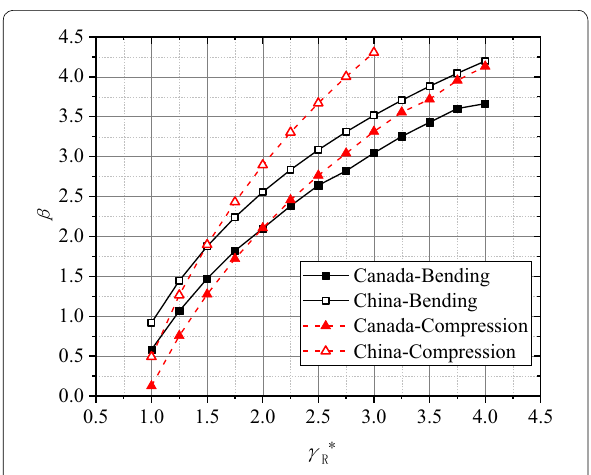
Fig. 2 Reliability results of western hemlock dimension lumber under dead load